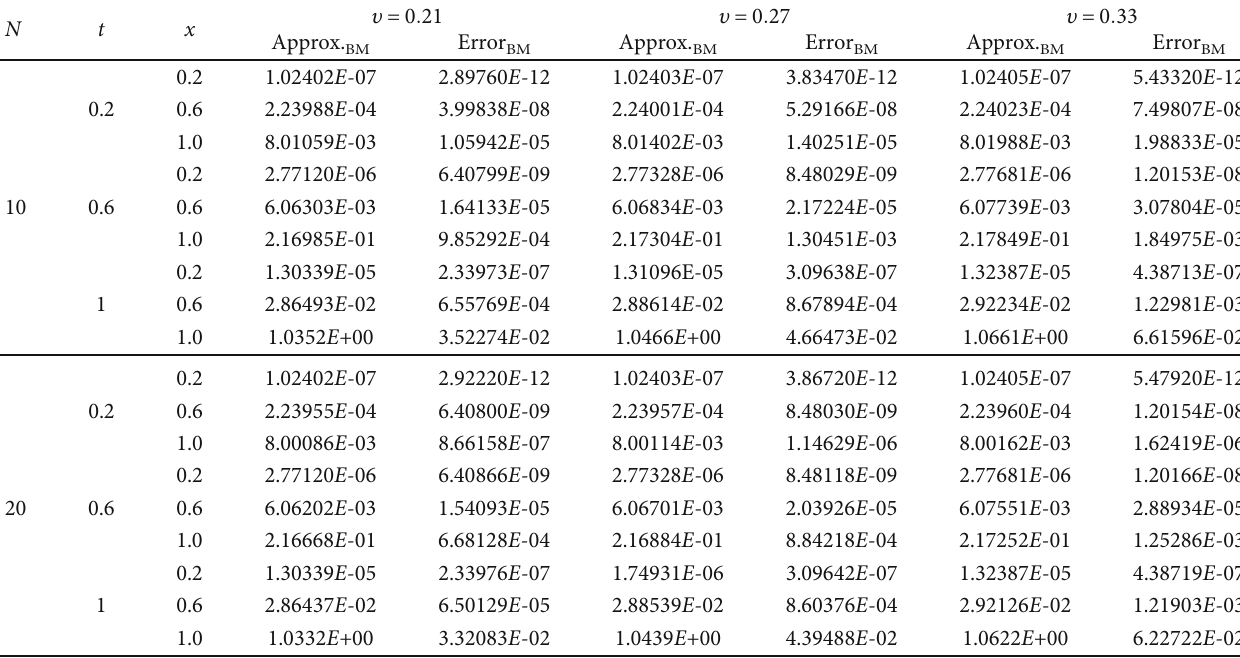
Table 2: The approximate values and the absolute relative error values using B-by-BM for nonlinear case ( k = 2 ).